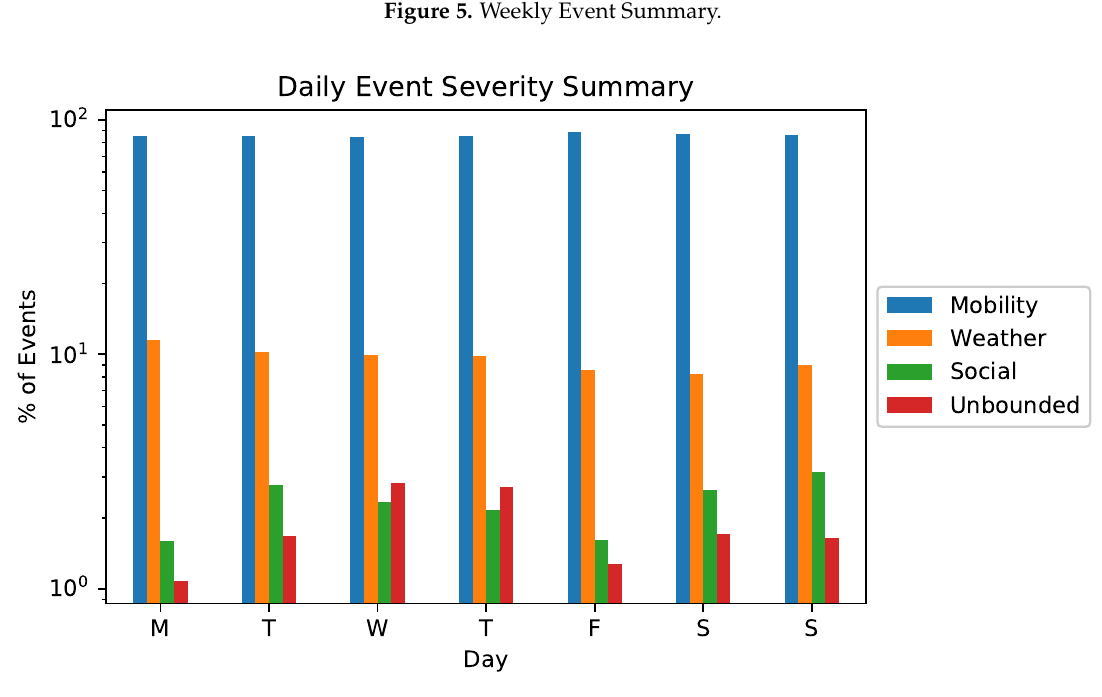
Figure 5. Weekly Event Summary.